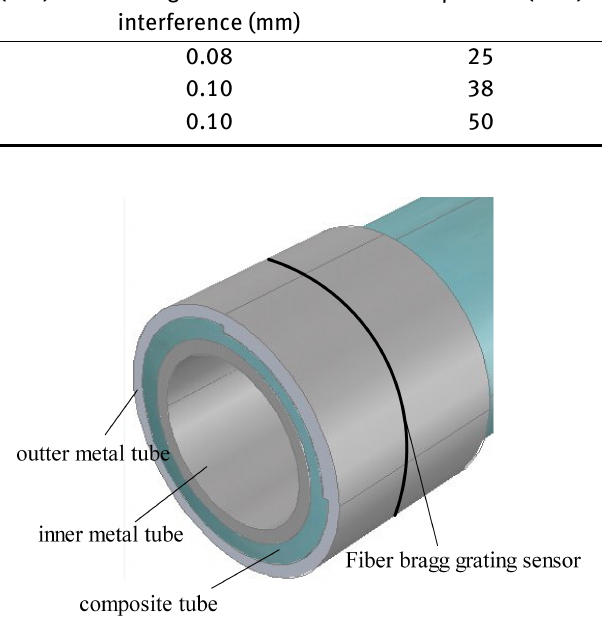
Figure 6: Distribution of Fiber Bragg Grating sensor on the outer metal